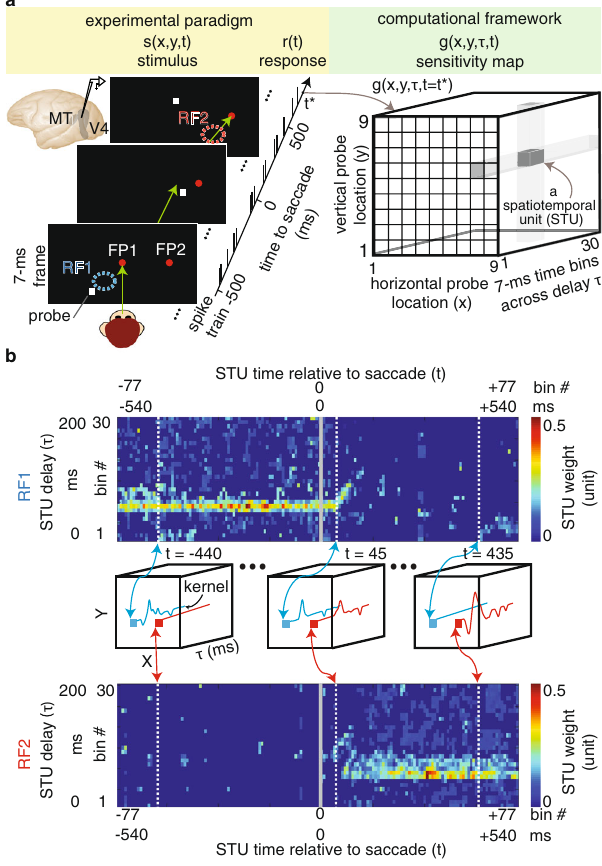
Fig. 1 Decomposing sensitivity maps of neurons across saccades. a Experimental paradigm: monkey saccades from a fi xation point (FP1) to a peripheral target (FP2). Throughout, visual probes (white squares) appear at pseudorandom locations. Green arrow shows gaze